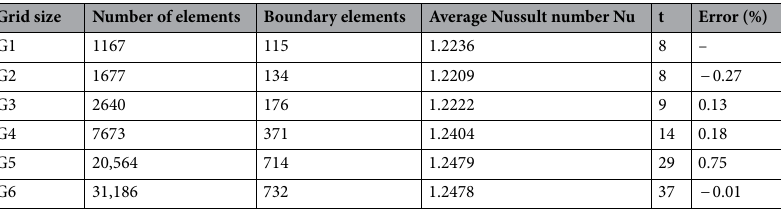
= 0.05, Ha = 60, Ω = 500, ϕ